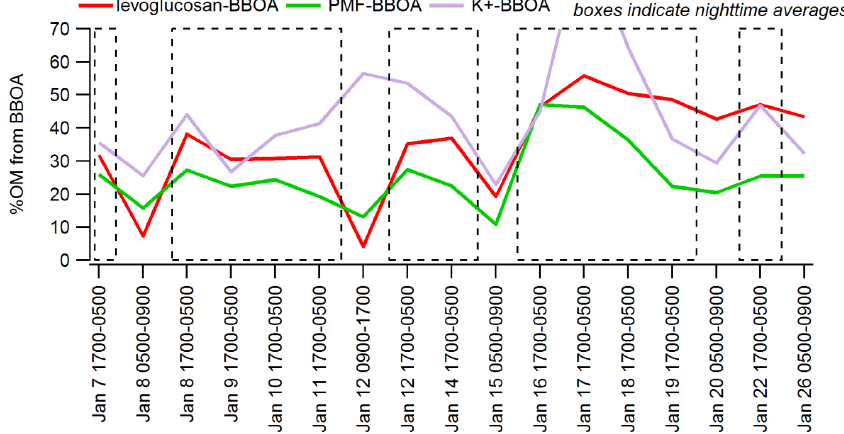
Figure 5. Percentage of OM apportioned by four methods for each time period where levoglucosan was quantified; boxes indicate nighttime averages (1700–0500 LST). Not shown is K-BBOA value of 100% apportioned OM on 17 January 1700-0500.